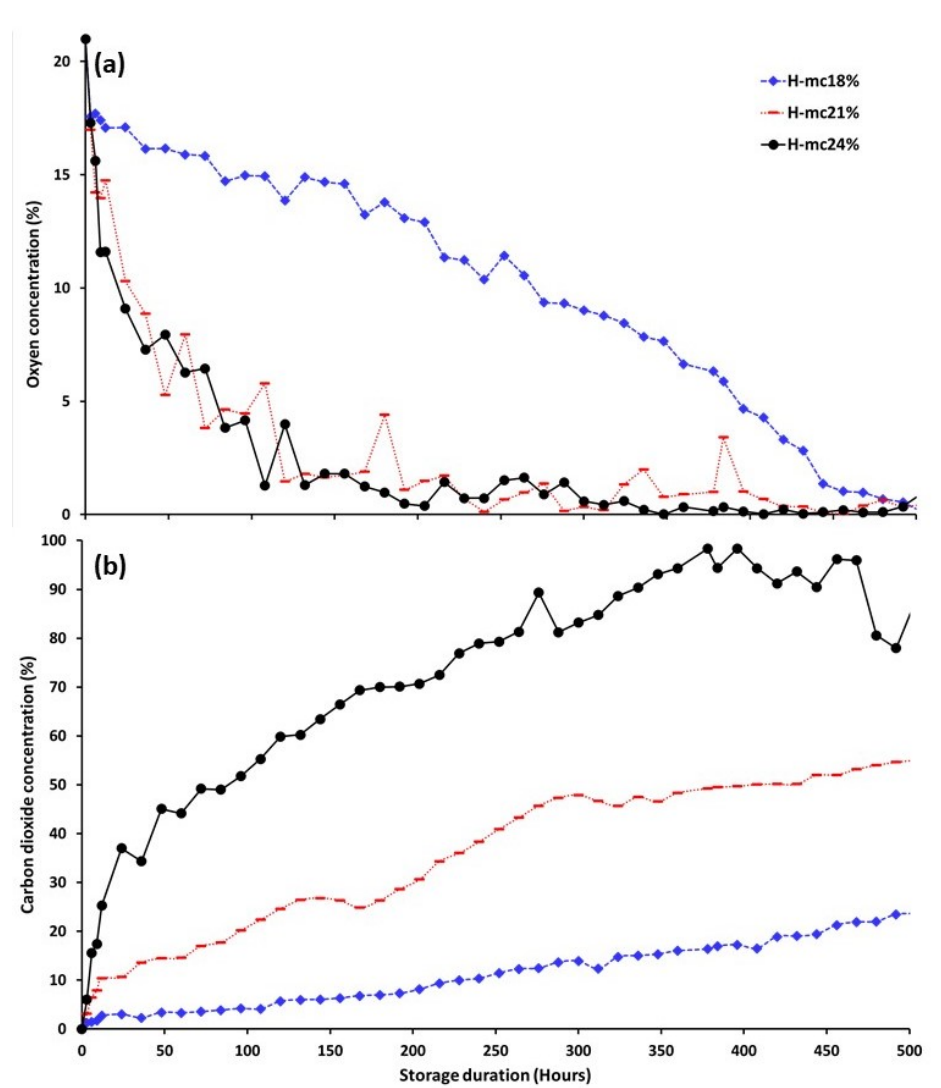
Figure 2. Oxygen ( a ) and carbon dioxide ( b ) levels in hermetic jars containing maize stored for up to 21 days at 18, 21, and 24% moisture